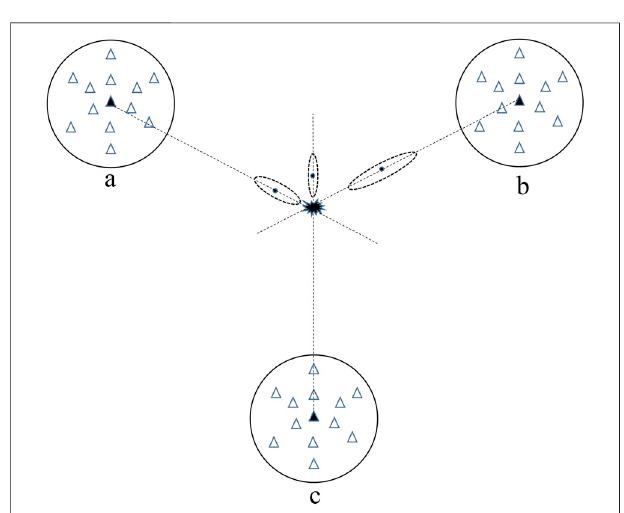
FIGURE 4 | Schematic diagram of the MCBP